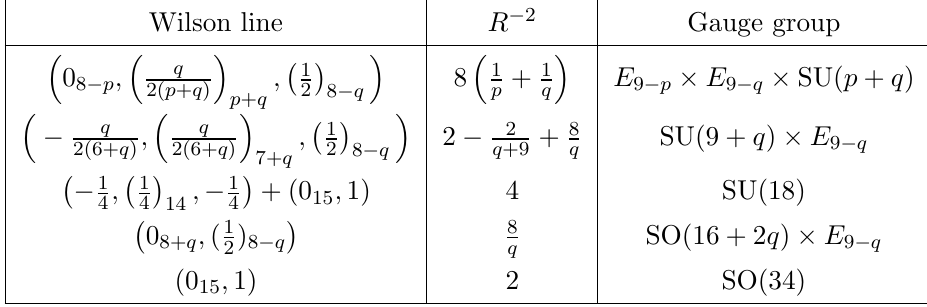
Table 1. Maximal enhancements for the SO(32)